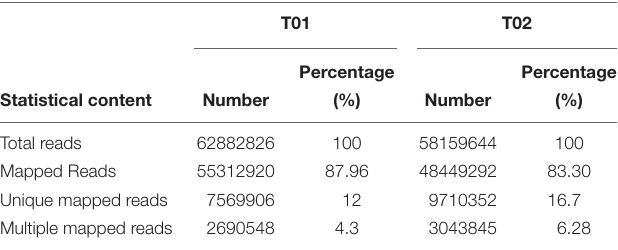
TABLE 1 | The distributions of mapped reads from T01 and T02.